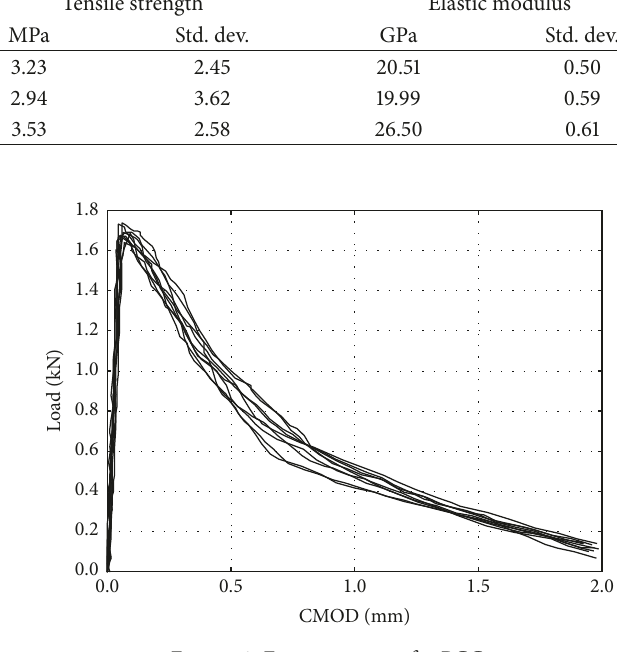
Figure 9: Fracture energy for PCC.